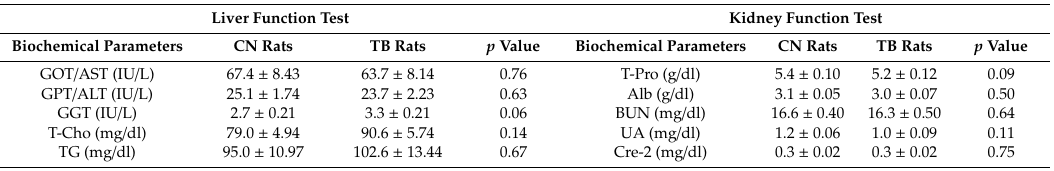
Table 3. Biochemical parameters for liver function and kidney function in experiment 2 for control rats (CN rats) and theobromine-fed rats (TB rats).